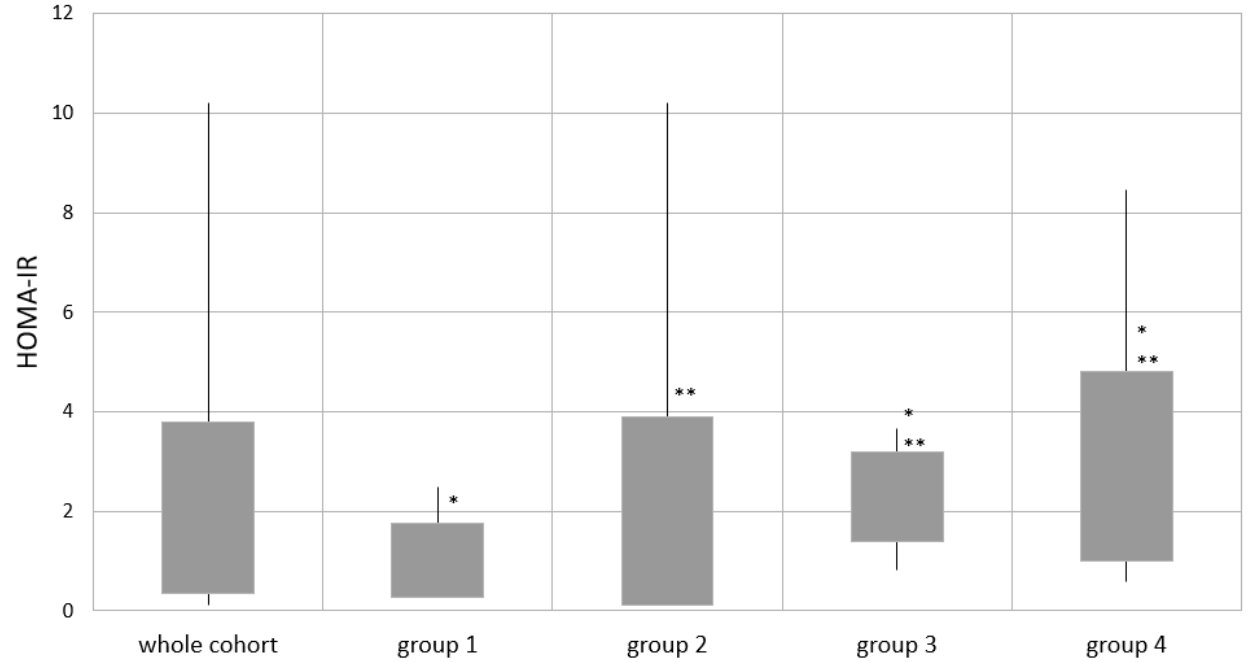
Figure 3. HOMA-IR in the whole study cohort and separate groups. the bottom of the box indicates -1 SDS; the top of the box, +1 SDS; and the vertical lines, minimal and maximal values. HOMA-IR—Homeostasis Model Assessment of Insulin Resistance; group 1: age ≤ 2 years; group 2: age >2 and ≤ 4.5 years; group 3: age >4.5 and ≤ 8 years; and group 4: age >8 years of life; p < 0.05 for the mean values: * group 1 vs. 3 and 1 vs. 4; ** group 2 vs. 3 and 2 vs. 4.